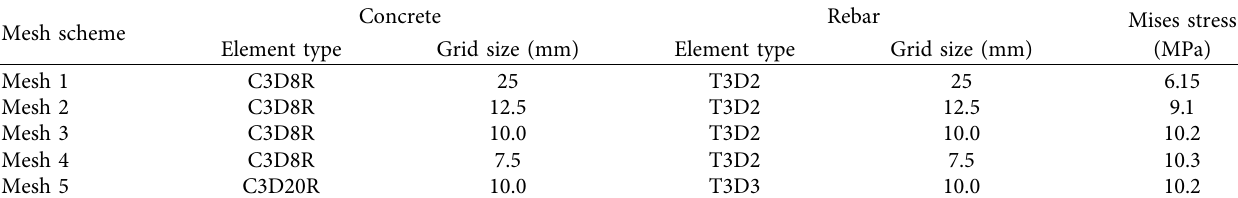
Table 3: Influence of element and mesh size on analysis results.